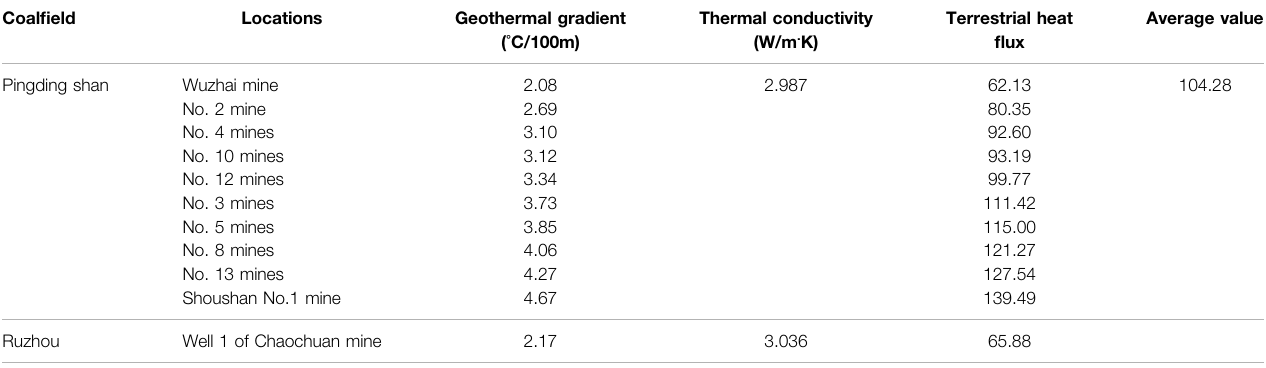
TABLE 5 | Calculated heat fl ow in Pingdingshan and neighboring mining areas (mw/m 2 ).